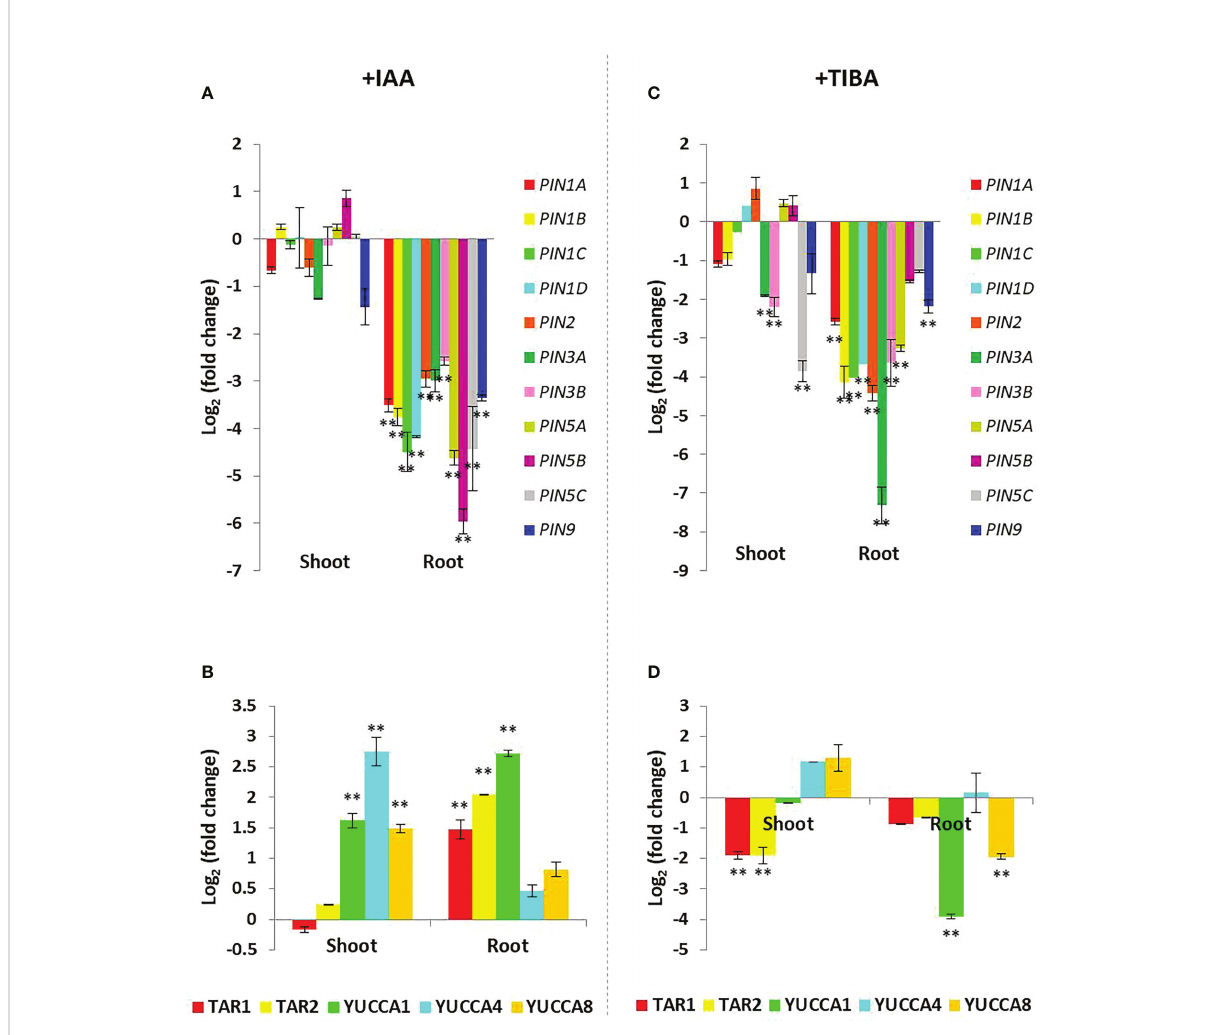
FIGURE 10 Expression pro fi ling of the PIN and IAA biosynthesis genes in the shoot and root tissues of rice seedlings grown over half MS media containing 4 mg/L IAA or 8 mg/L TIBA for a duration of 15 days. (A) Downregulation of the PIN genes in IAA-treated rice seedlings (n = 3) as measured by qRT-PCR. The downregulation is more prominent in the root tissues as compared to the shoot tissues. (B) Upregulation of the IAA biosynthesis genes in IAA-treated rice seedlings (n = 3). (C) Downregulation of the PIN genes in TIBA-treated rice seedlings (n = 3) as measured by qRT-PCR. The downregulation is more prominent in the root tissues as compared to the shoot tissues. (D) Downregulation of the IAA biosynthesis genes in TIBA-treated rice seedlings (n = 3). Signi fi cant changes are marked with asterisks